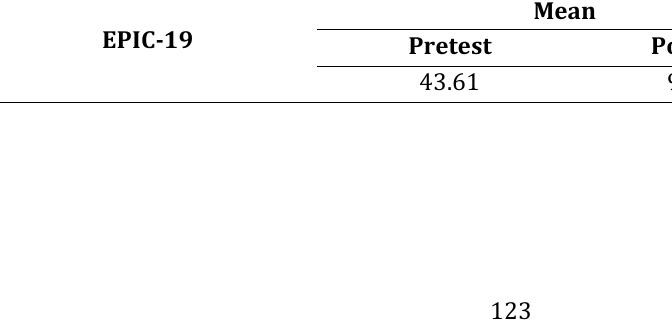
The Level of Self-Care Practice in the Pretest and Posttest